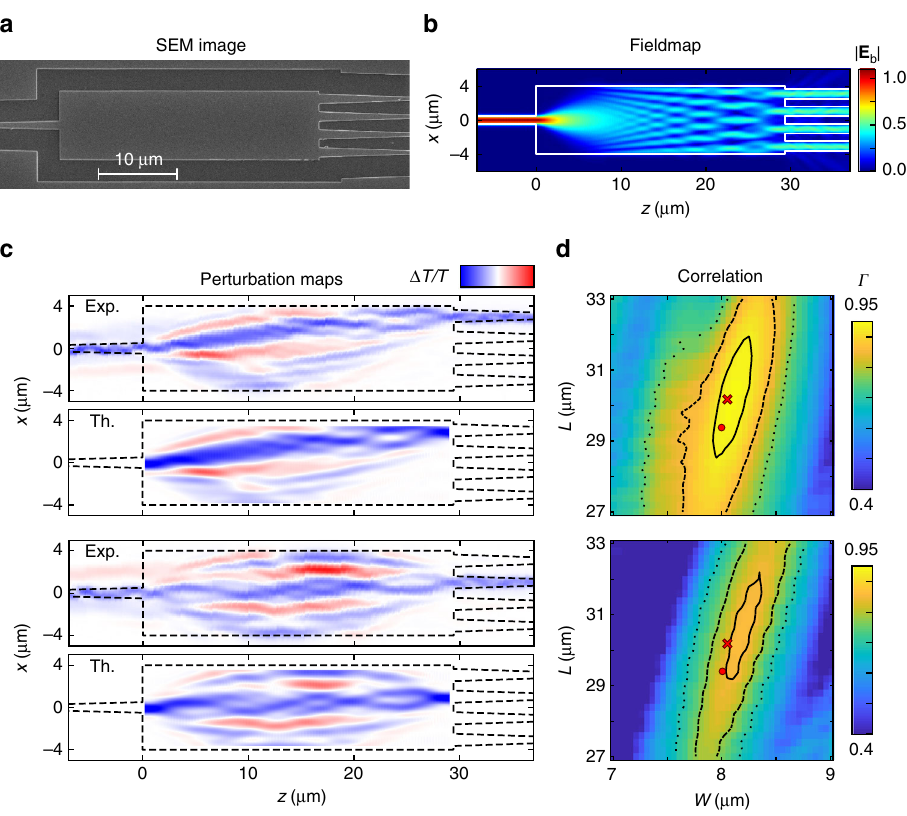
Fig. 3 Experimental investigation of a 1 × 4 MMI and comparison with predictions. a SEM image of the MMI. The design parameters are L = 29.4 μ m and W = 8.0 μ m but the SEM image shows fabricated length L = 30.2 μ m and width W = 8.05 μ m. b Calculated fi eldmap of the design device for ingoing excitation by the fundamental mode of the input waveguide. c Experimental and theoretical perturbation maps for the transmittance between the input waveguide fundamental mode and the top and second top waveguides fundamental modes, showing a remarkable agreement in their details. The amplitude of the color bar is ±0.25 for the experimental maps and ±0.35 for the theoretical ones. d 2D maps of the correlation Γ for varying theoretical MMI region dimensions L and W , for the two considered output modes. The red dot and cross indicate the MMI design and SEM measured dimensions, respectively, and the contour lines indicate a 2% (solid), 10% (dash), and 20% (dot) decrease of the correlation with respect to the maximum As an illustration of the capabilities of the technique, we fi rst investigate a single-input quadruple-output (1 × 4) MMI as shown in the scanning electron microscopy (SEM) image of Fig. 3a. The MMI is designed to produce an equal split of intensity coupled to the four output ports. The corresponding multimode interference pattern in the device is shown via the calculated fi eldmap in Fig. 3b. This local fi eld pattern would be obtained using conventional scanning near- fi eld optical micro- scopy. As discussed above, perturbation maps show the sensitivity of a speci fi c output port transmittance, Δ T , to a local perturbation. The perturbation maps of the differential transmis- sion, Δ T / T , obtained when detecting a speci fi c output transmit- tance while scanning the pump spot over the device, are shown in Fig. 3c for the fi rst and second output waveguide modes (the remaining two are given in the Supplementary Note 2). We obtain detailed maps showing structures on the length scale of the pump spot size of 740 nm. The experimental maps can be directly compared with predictions using Eq. (11). The theoretical maps were calculated for design parameters L = 29.4 μ m and W = 8.0 μ m, and experimentally determined values of d = 740 nm and Δ n = − 0.25 (see details in the Methods section). The amplitudes of the experimental and theoretical maps shown in Fig. 3c differ by about 0.1, which is likely to be due to the approximate values taken to reproduce the experiments. However, the experimental and theoretical maps show a remarkable level of agreement in their details and in relative values. This is a clear indication that